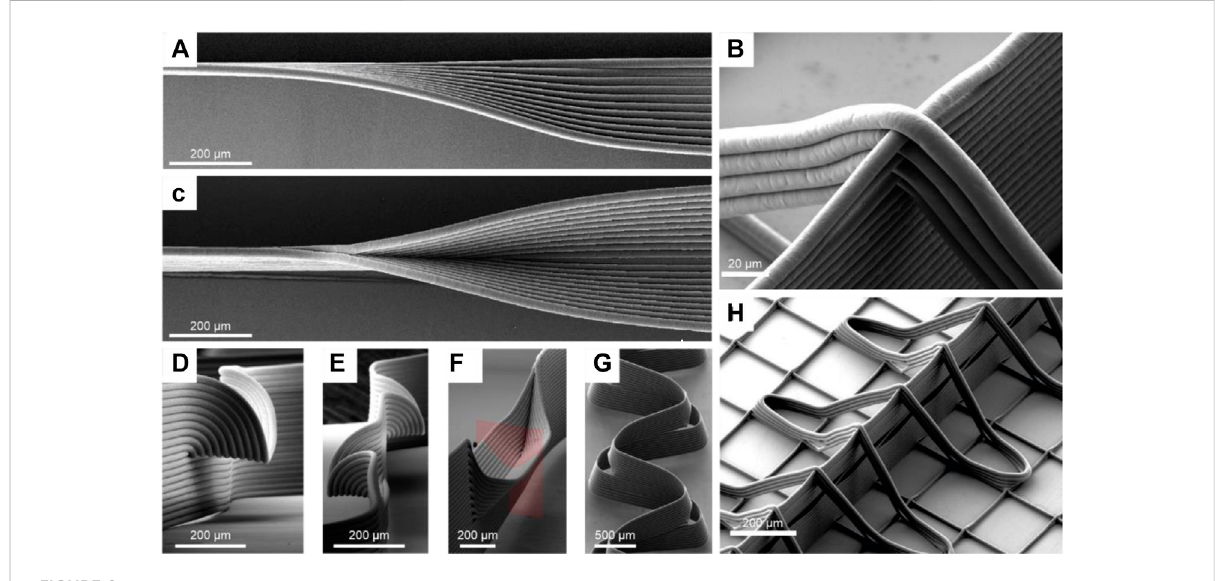
FIGURE 2 Microscale layershifting (Liashenko et al., 2020a) and out-of-plane- fi ber-deposition (Ruijter et al., 2018): MEW structures such as overhangs (A,D,E) , branching walls (C,F) , tilted walls (G) are shown that are fabricated by deliberately offsetting the print path for each layer in a process termed “ microscale layer shifting ” . Images (B,H) show out-of-plane- fi bers, fabricated to adapt material properties, enabled by the contactless fabrication characteristics of